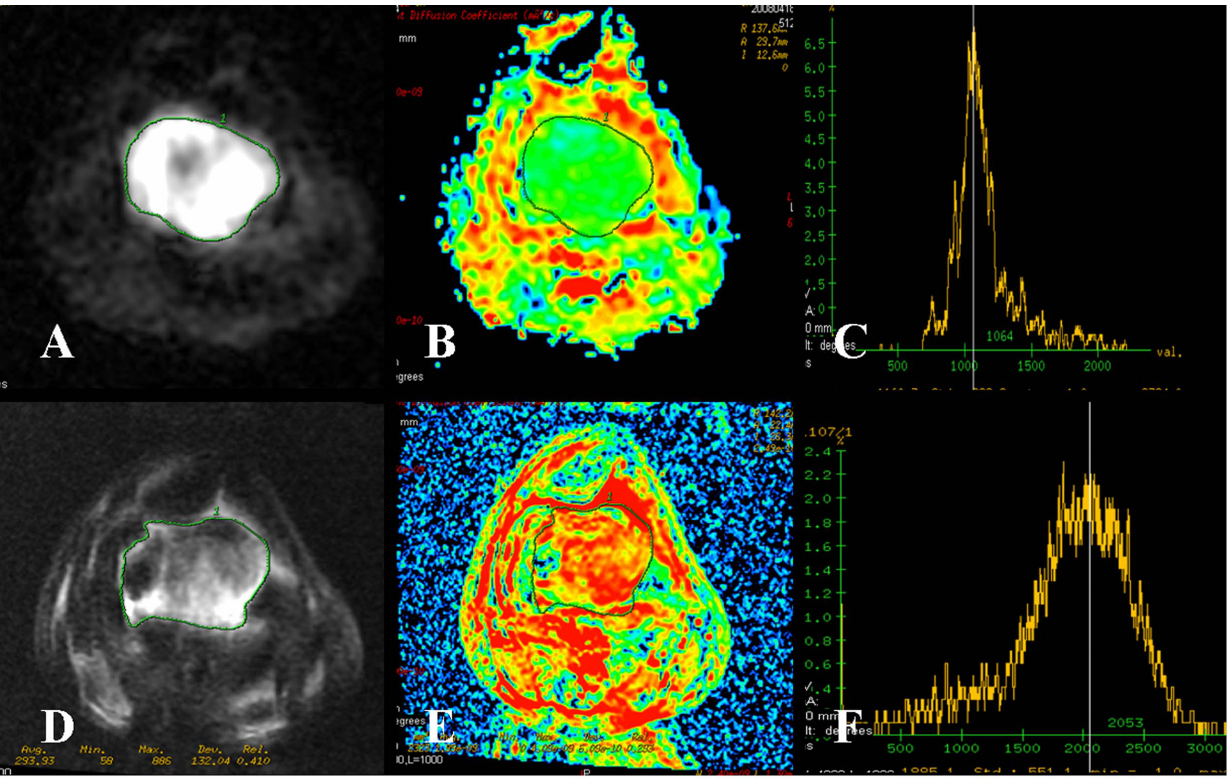
Figure 2. Osteosarcoma of the distal femur in a 24-year-old man with good response. ( A , C ) DWI map, ADC map and ADC histogram before neoadjuvant chemotherapy. The signal intensity of tumor on DWI map was high. The ADC value of the whole tumor was 1.12 6 10 2 3 mm 2 /s with a green area. The ADC histogram was high and sharp. ( D , F ) DWI map, ADC map and ADC histogram after neoadjuvant chemotherapy. The signal intensity of tumor on DWI map was decreased. The ADC value of the whole tumor was increased to 1.99 6 10 2 3 mm 2 /s with a subtotal red area. The ADC histogram was short, wide and moving to the right of the coordinate. Tumor necrosis rate of 92% was confirmed by postoperative pathological evaluation. The effectiveness of neoadjuvant chemotherapy was good.